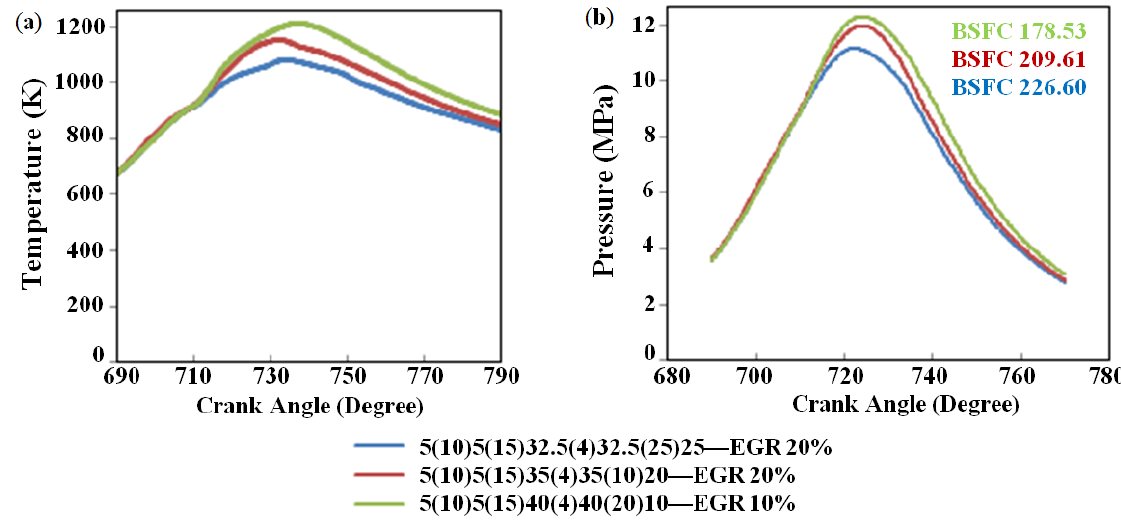
Figure 9. Three different trends for (a) temperature and (b) pressure [and its correlation with Brake Specific Fuel Consumption